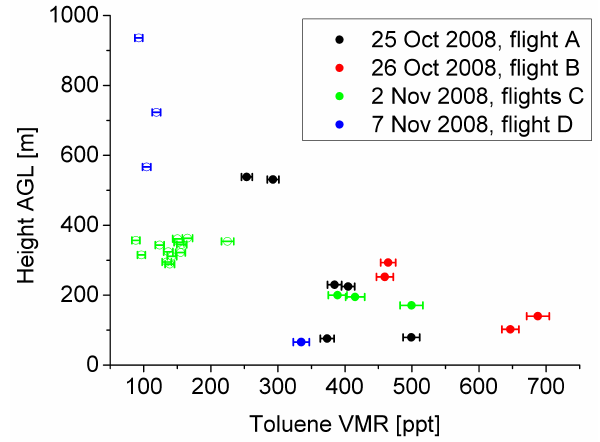
Fig. 12. Histogram of all toluene δ 13 C values measured during ZEPTER-2; the mean error is 0 . 53‰ (i.e. half the bin width).